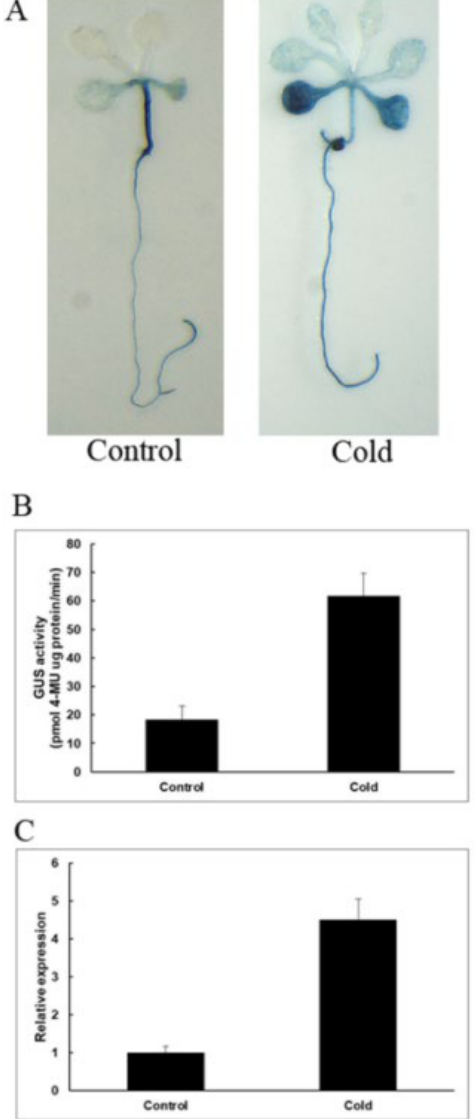
Figure 9. Induction and expression pattern of PeNAC-19 under low temperature (4 °C for 36 h). ( A ) GUS staining of transgenic Arabidopsis. ( B ) GUS enzyme activity analysis of transgenic Arabidopsis thaliana. ( C ) Expression of PeNAC-19 under the cold stress. Means denoted by the same letter are not significantly different at p < 0.05 as determined by Duncan’s multiple range test.